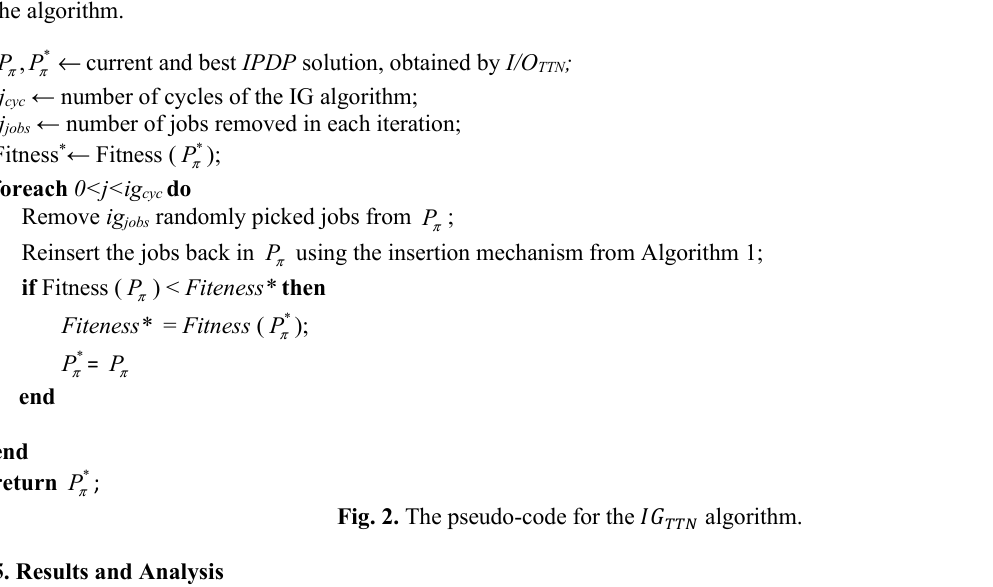
Fig. 2. The pseudo-code for the 𝐼𝐺